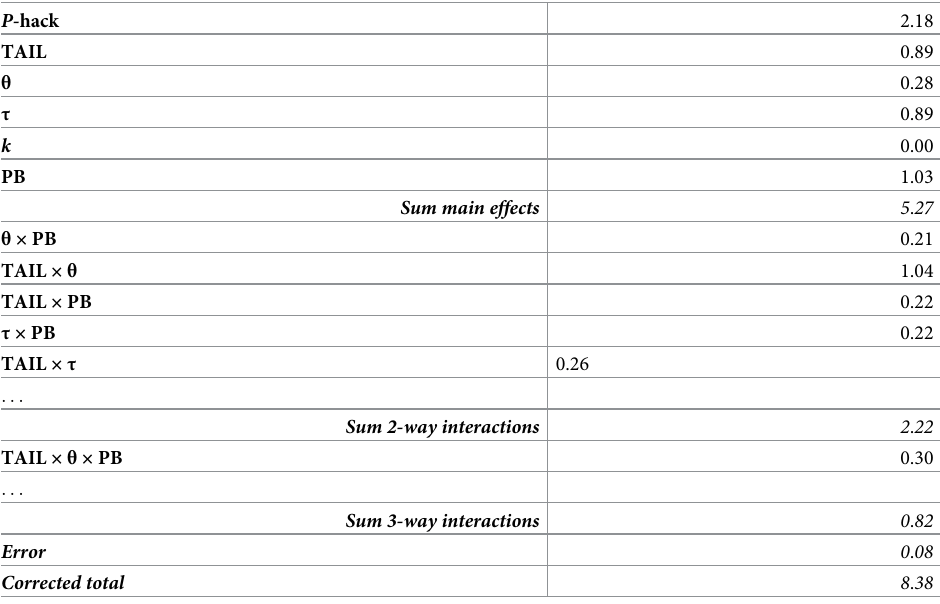
Table 4. The relative importance of design factors for d bias (selected sum of squares from six-factorial between- subjects ANOVA). Data are shown for DL but were very similar across all heterogeneity estimators. P -hack 2.18 TAIL